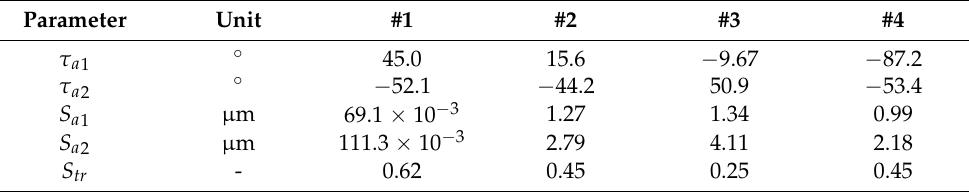
Table 2. Corresponding values of τ a 1 , τ a 2 , S a 1 , S a 2 , and Str for the samples.